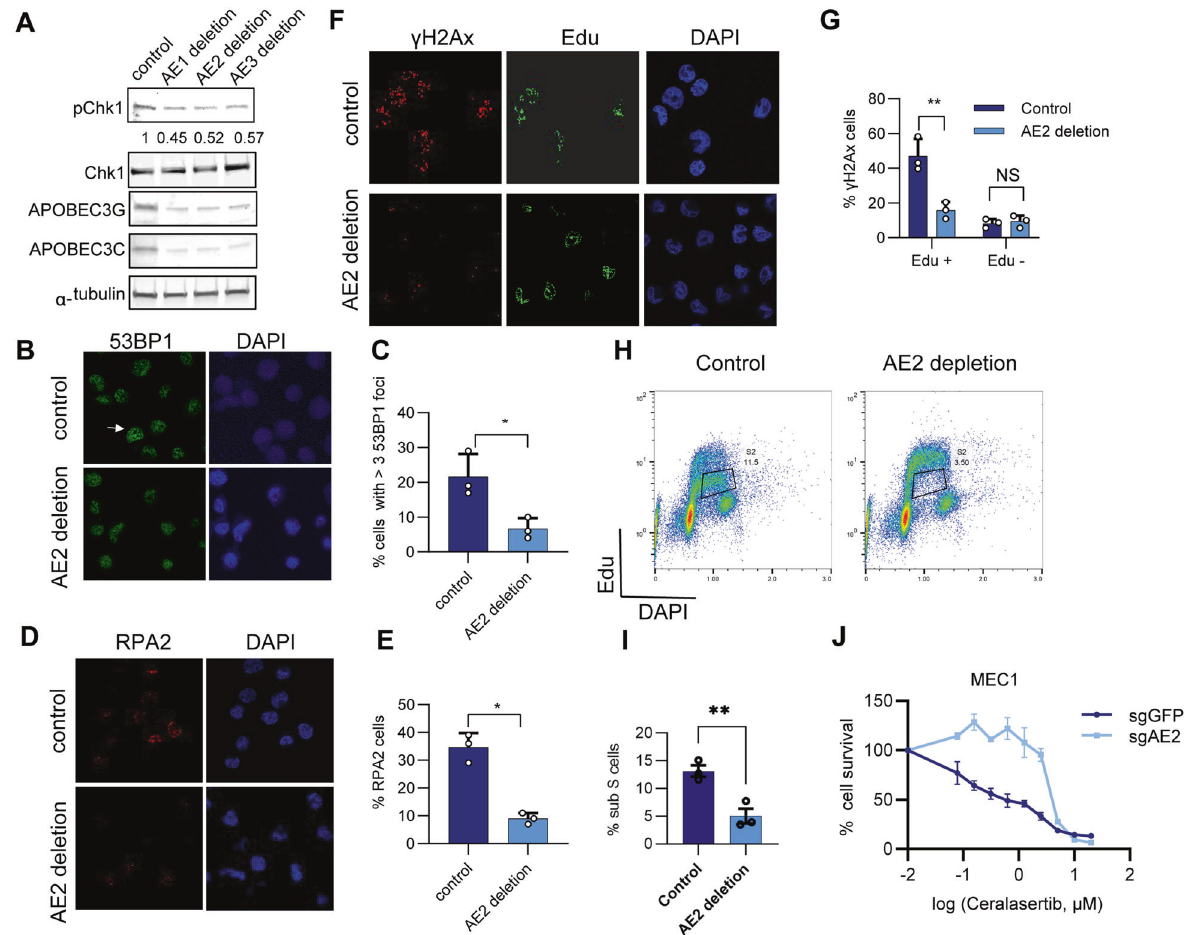
Fig. 5 APOBEC3 enhancers contribute to the replication of stress-induced DNA damage in MEC1 cells. A Western blot analysis of pChk1 level in the indicated AE-deleted MEC1 cells. B Representative images of 53BP1 staining in AE2 depleted and control MEC1 cells. The intensity of pChk1 was quanti fi ed and normalized against total Chk1, with the normalized intensity of control cells set to 1. C The quanti fi cation of cells with more than three 53BP1 foci in panel ( B ). One hundred cells were counted per experiment, n = 3 independent experiments. D Representative images of RPA staining in AE2 depleted and control MEC1 cells. E The quanti fi cation of cells with RPA2 in panel ( D ). One hundred cells were counted per experiment, n = 3 independent experiments. F Representative images of γ H2AX and Edu staining of AE2 depleted and control MEC1 cells treated. Cells were incubated with 10 µM Edu for 30 min before harvest. G The quanti fi cation of S phase cells with γ H2AX in panel ( F ), 100 cells were counted per experiment, n = 3 independent experiments. H AE2 was deleted and control MEC1 cells were incubated with Edu for 30 min before the cells were stained with Click-it Alexa 488 azide and DAPI. I The quanti fi cation of sub-S phase cells percentage in ( H ) J AE2 deleted and control MEC1 cells were incubated with ATR inhibitor Ceralasertib as indicated for 5 days, and the cell viability was determined by